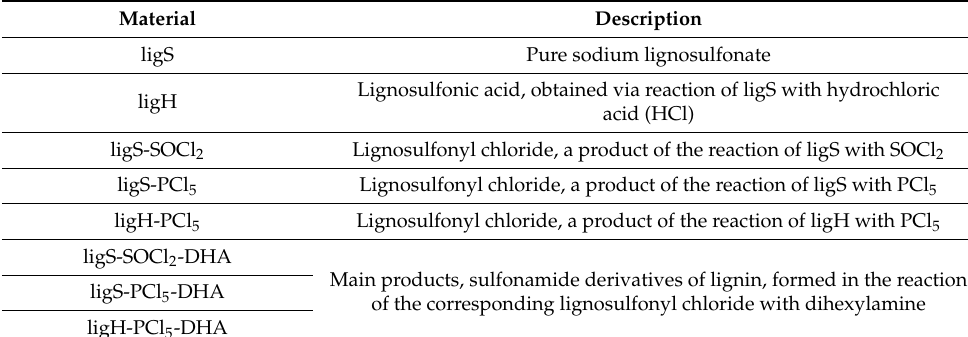
Table 1. Description of the materials investigated in the